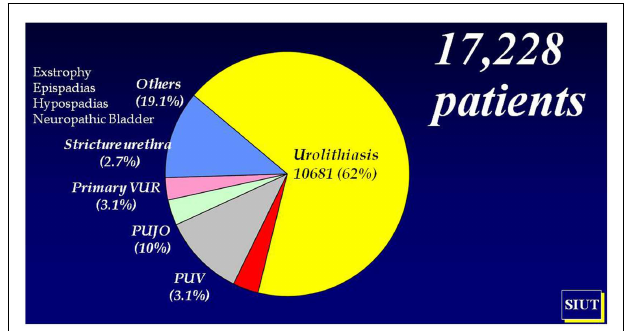
FIGURE 1 | Pediatric urological workload (1998–2013)